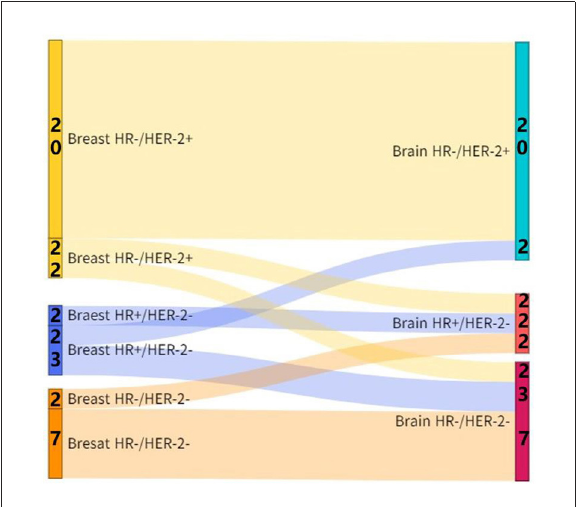
TABLE 3 The receptor conversion trend between the primary lesions and brain metastatic lesions.